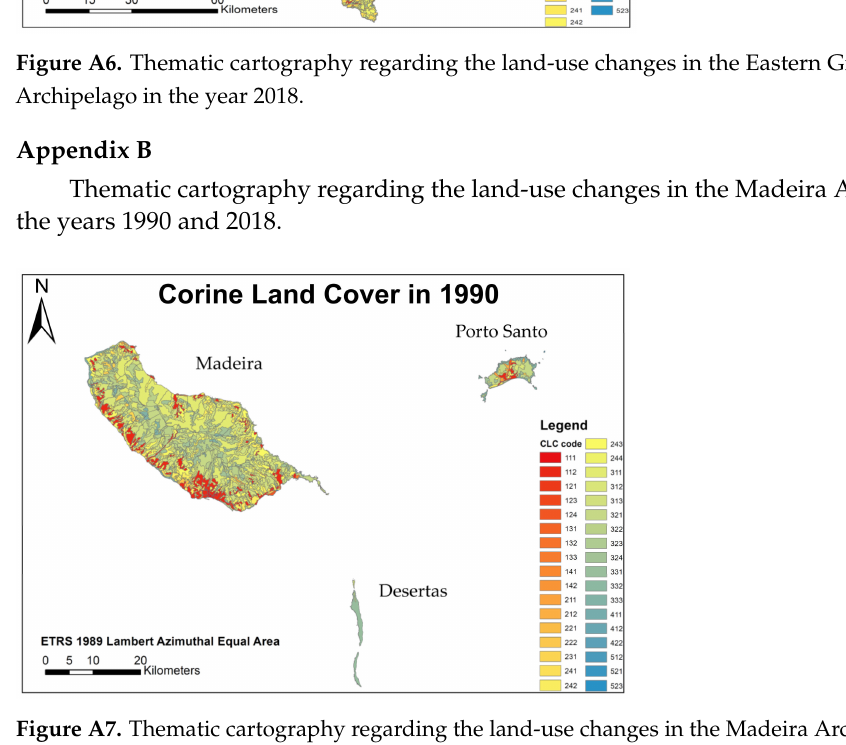
Figure A7. Thematic cartography regarding the land-use changes in the Madeira Archipelago in the year